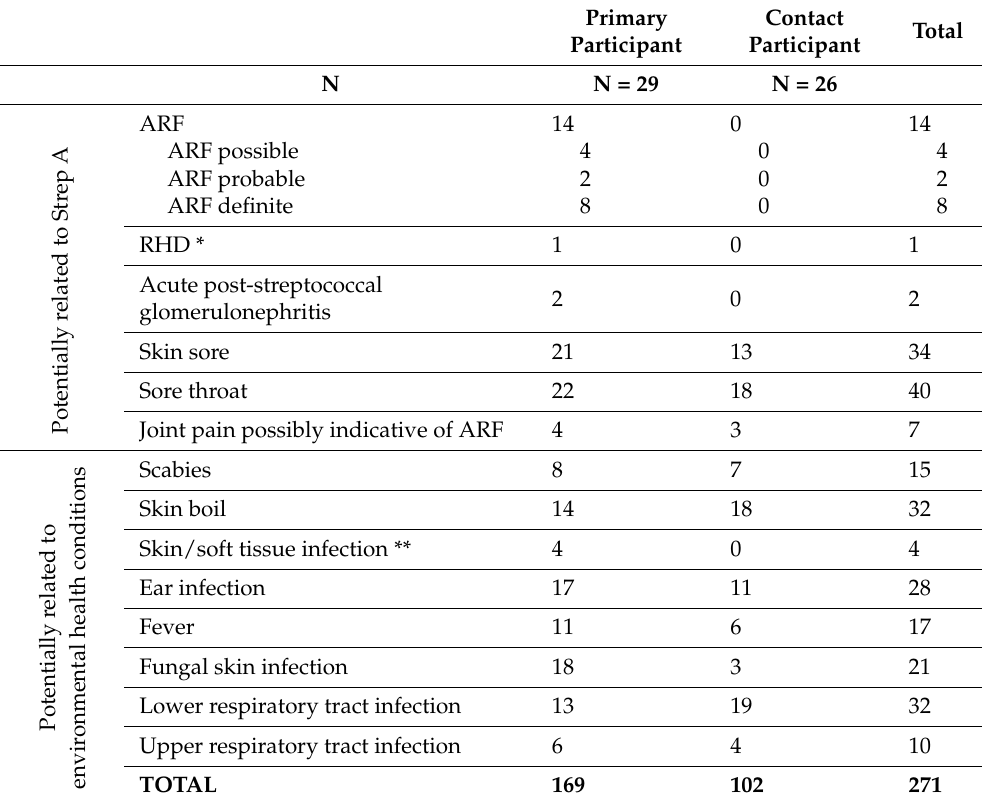
Table 2. Clinic-reported relevant diagnoses during the whole study.